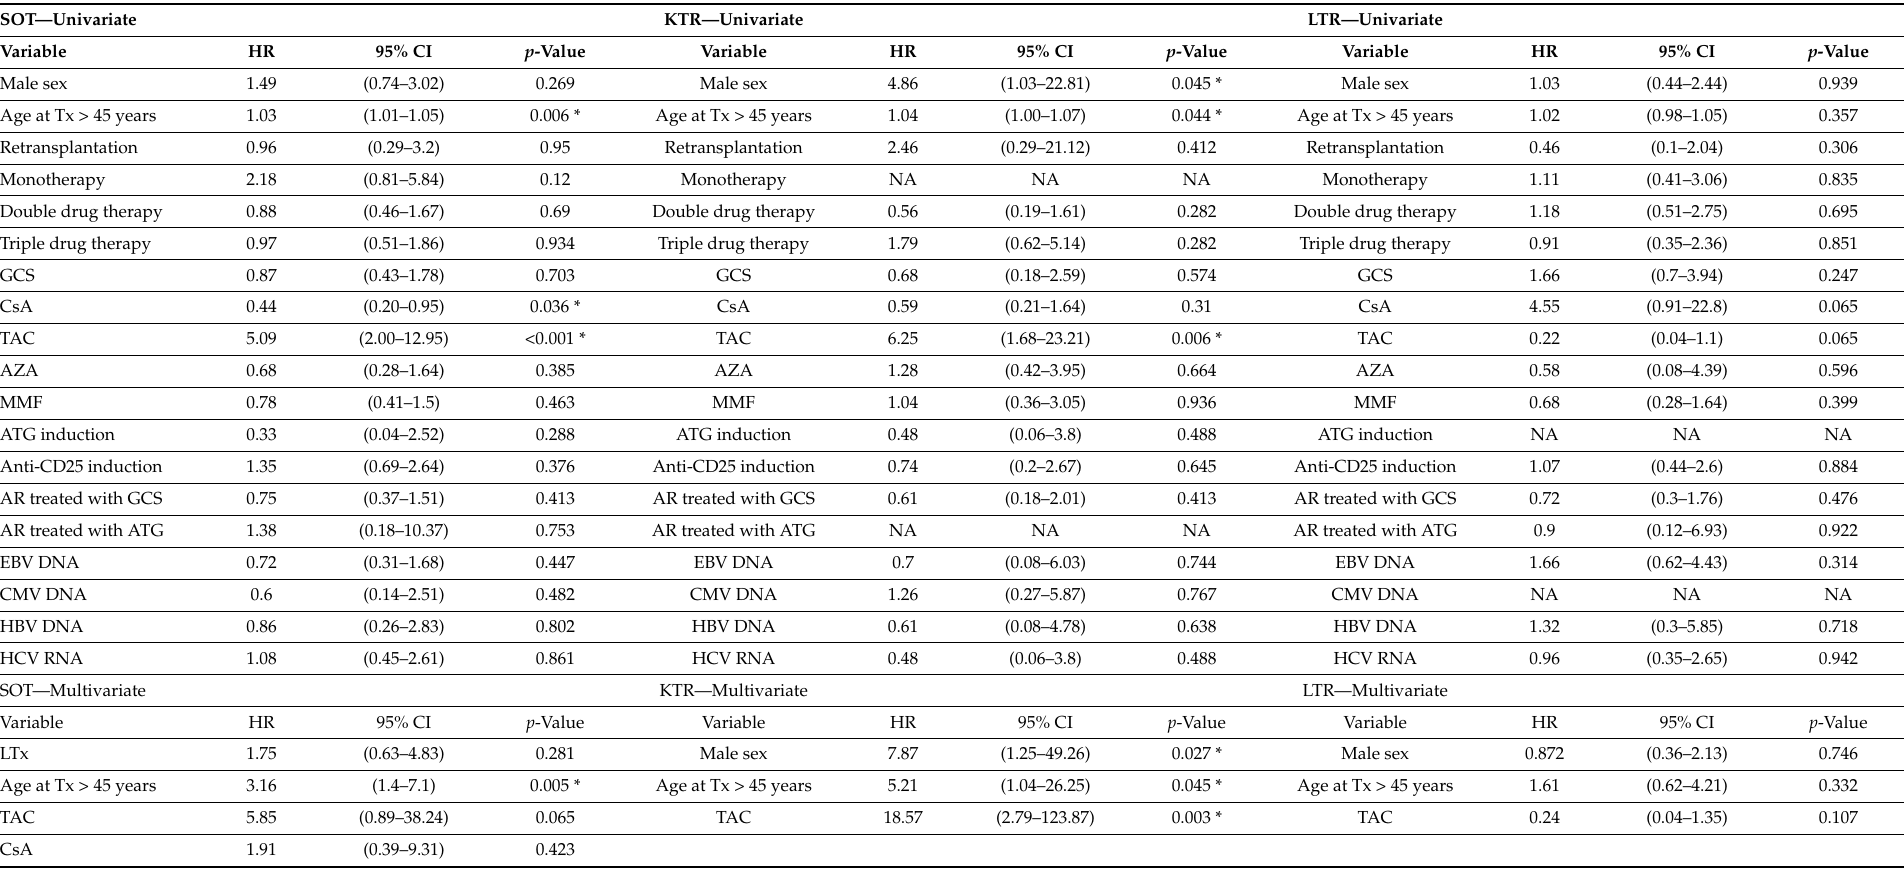
Table 3. Univariate and multivariate Cox proportional hazards models of the effect of variables on the PTLD time of